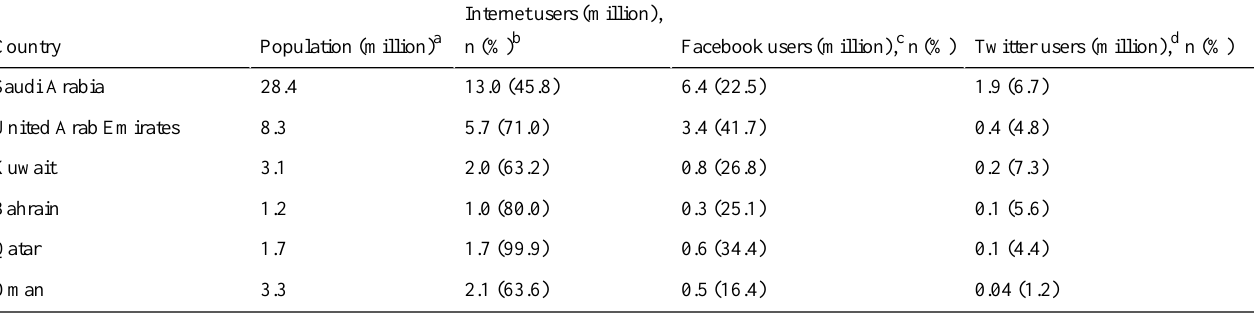
Table 2. The use of Internet and social media platforms in the GCC